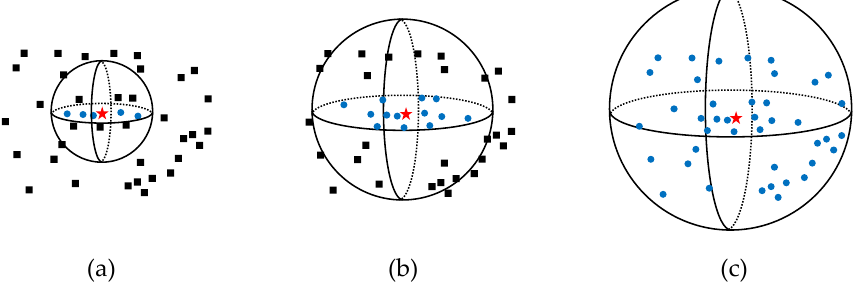
Figure 4. Neighborhoods at different scales. In this representation, the red star is the centroid point of the neighborhood, the blue points are the neighbors within the local neighborhood, and the black points are the outside points of the local neighborhood. In the figure, ( a – c ) represent different